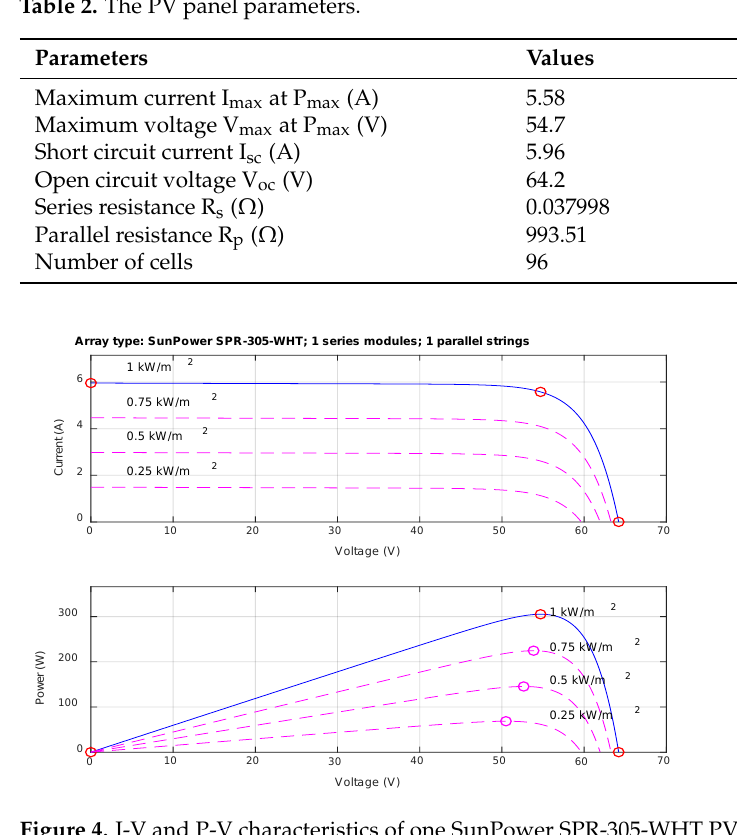
Figure 4. I-V and P-V characteristics of one SunPower SPR-305-WHT PV module.